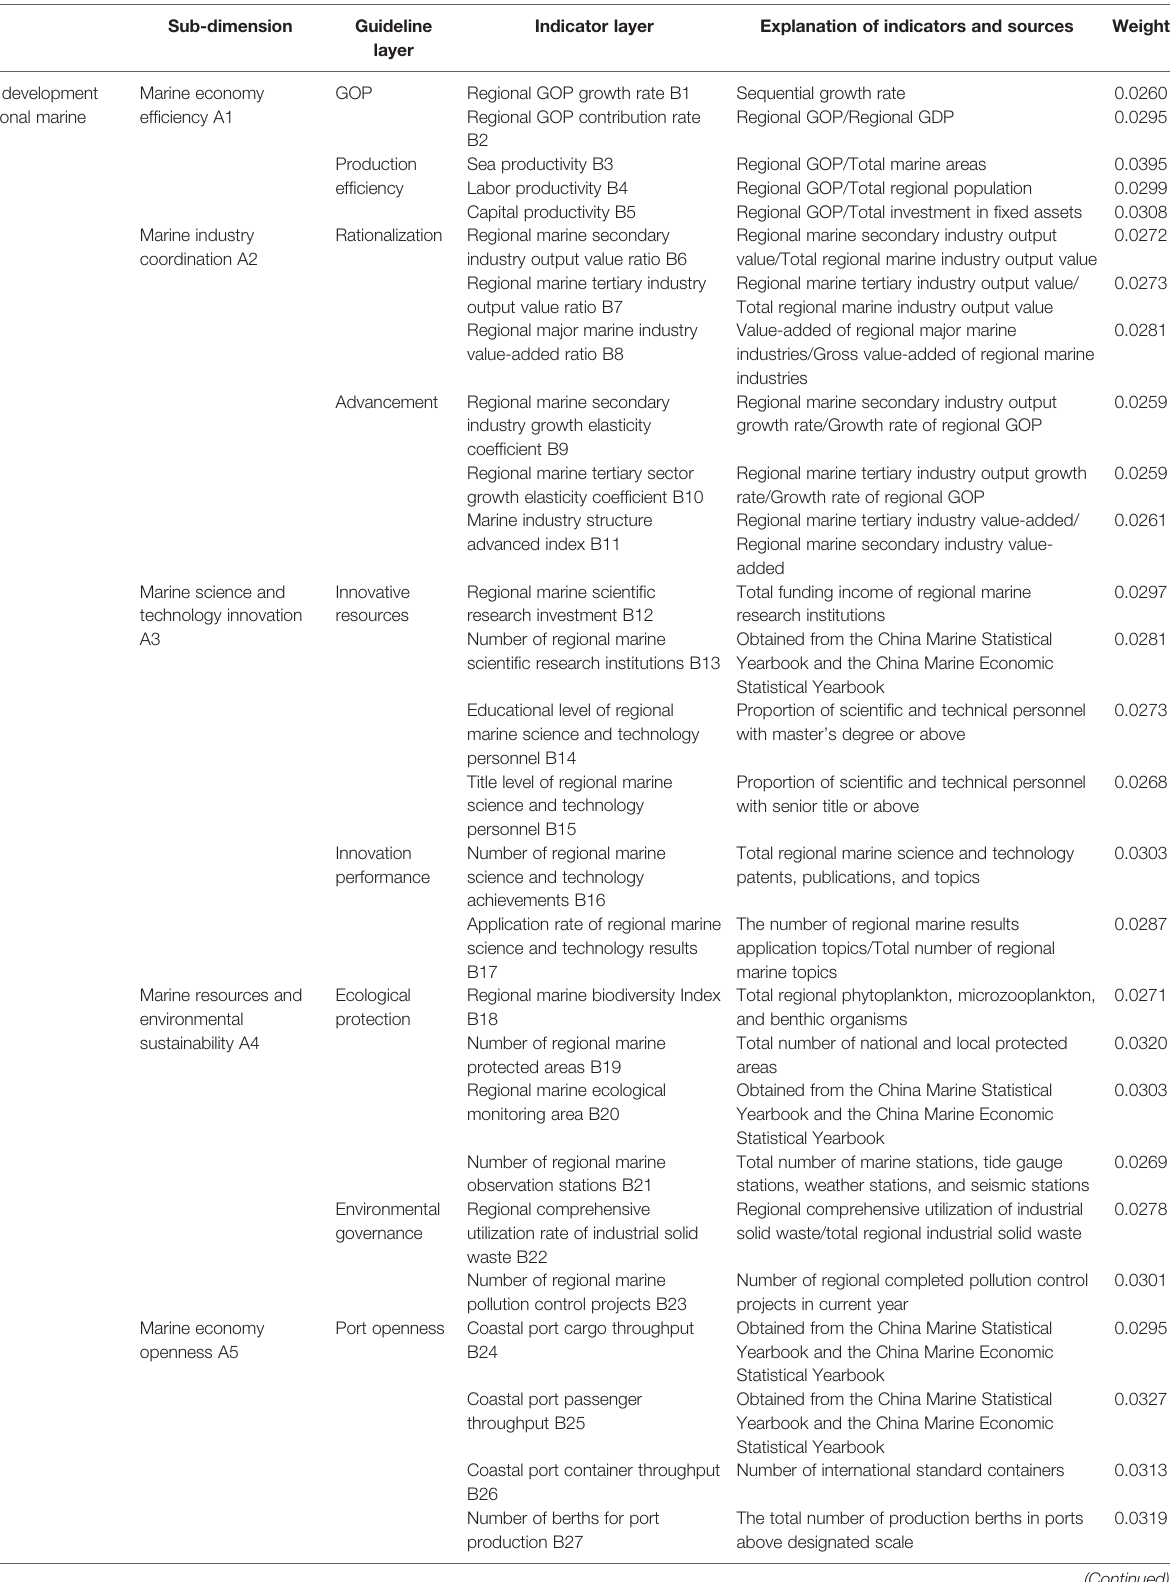
TABLE 1 | Evaluation index system for the high-quality development level of the regional marine